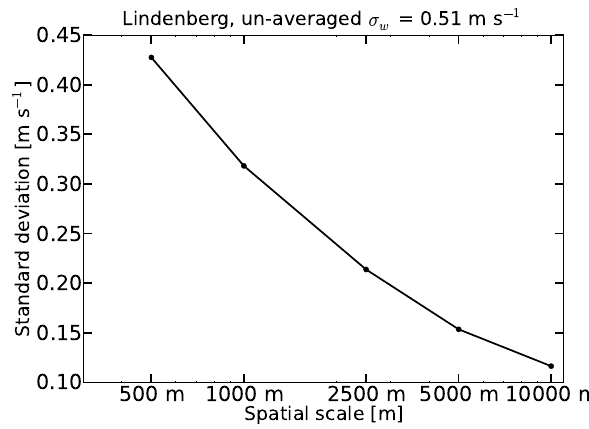
Fig. 9. Case study for Lindenberg, 29–30 January 2008: σ w in averaged observations as a function of the spatial averaging scale. For AROME, σ w in the corresponding case is approximately 0 . 08 m s − 1